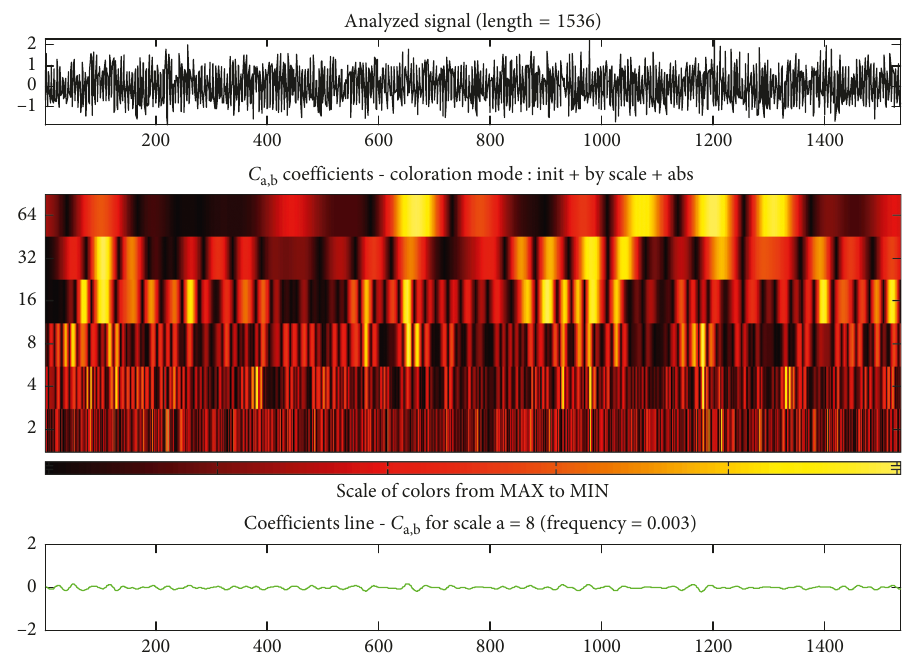
Figure 15: The time-frequency diagram of acceleration for the roller bearing with bruise on the inner